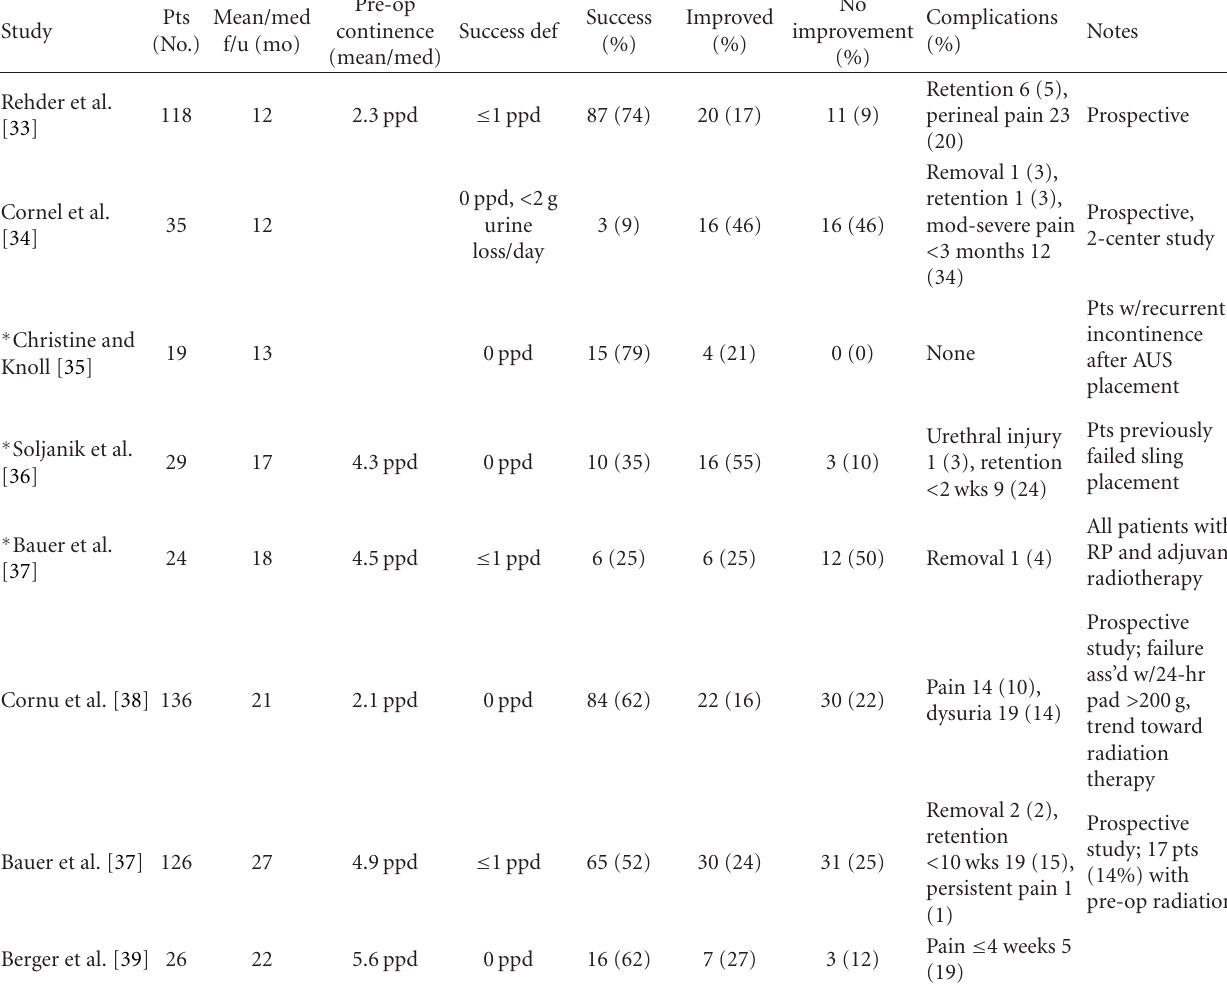
Table 2: Comparison of results of retrourethral transobturator sling placement in adult males with SUI. Study Rehder et al.